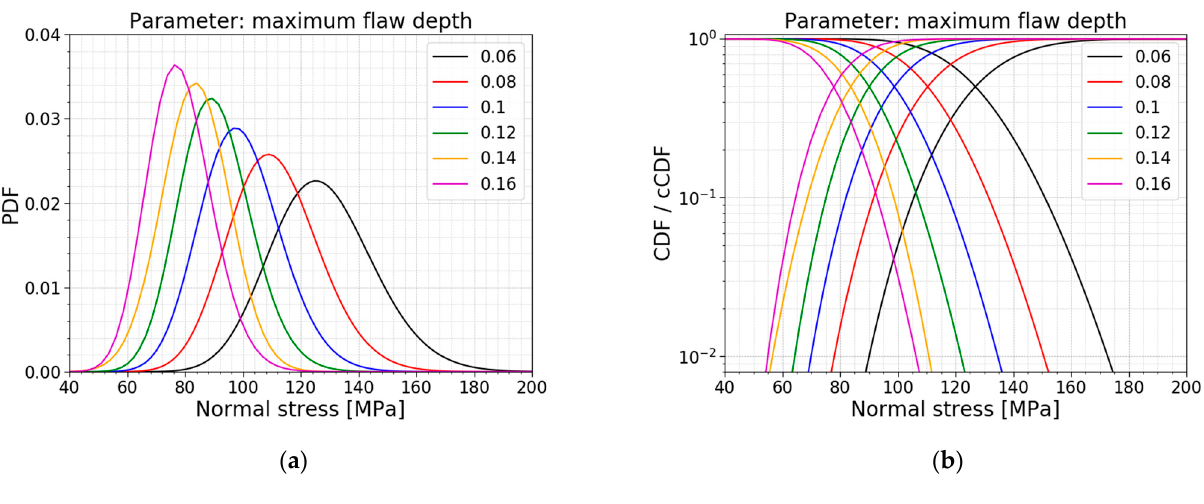
Figure 25. ( a ) PDF and ( b ) CDF for a varying maximum flaw depth.